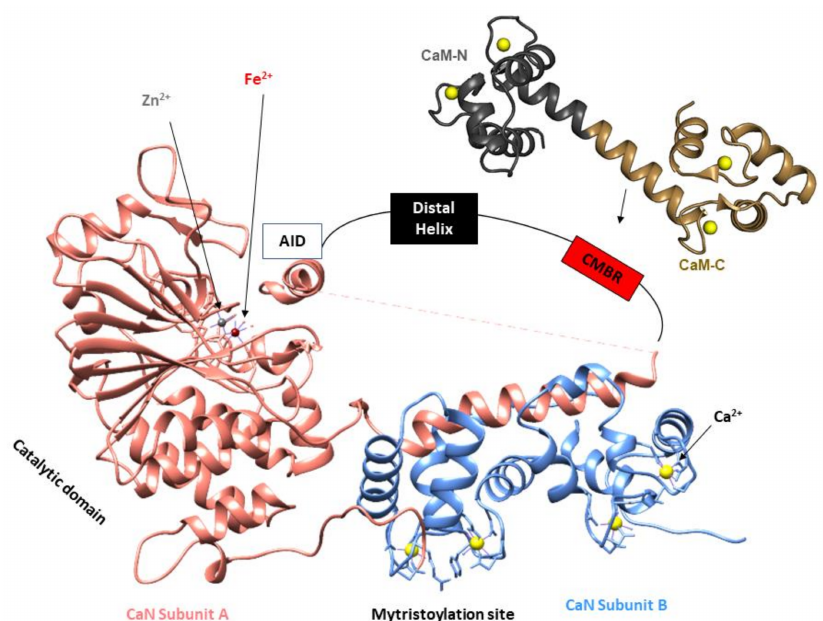
Figure 2. Diagram illustrating the key components of the CaN heterodimer (developed from PDB ID: 1AUI [16]). CaN A shown in salmon, CaN B shown in blue, Auto-Inhibitory Domain (AID), Calmodulin-Binding Region (CMBR). Due to